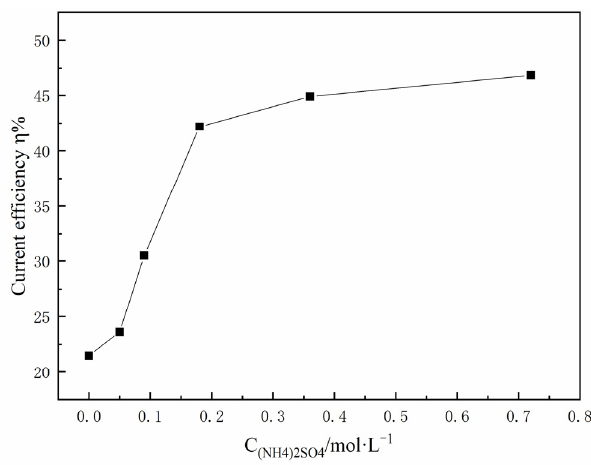
Figure 9. Effect of different concentrations of (NH 4 ) 2 SO 4 on the current efficiency of Fe-Co alloy. Figure 9. E ff ect of di ff erent concentrations of (NH 4 ) 2 SO 4 on the current e ffi ciency of Fe-Co alloy.